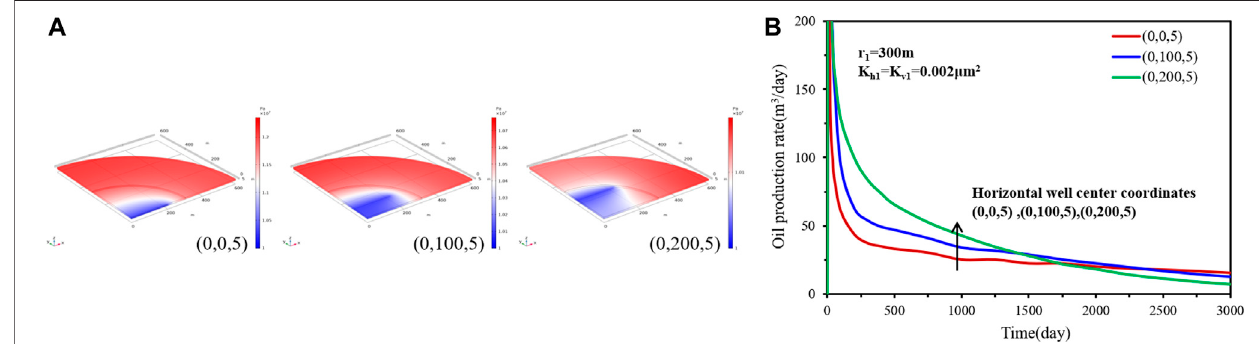
FIGURE 6 | Effect of horizontal well position on (A) transient pressure and (B) rate decline performance.